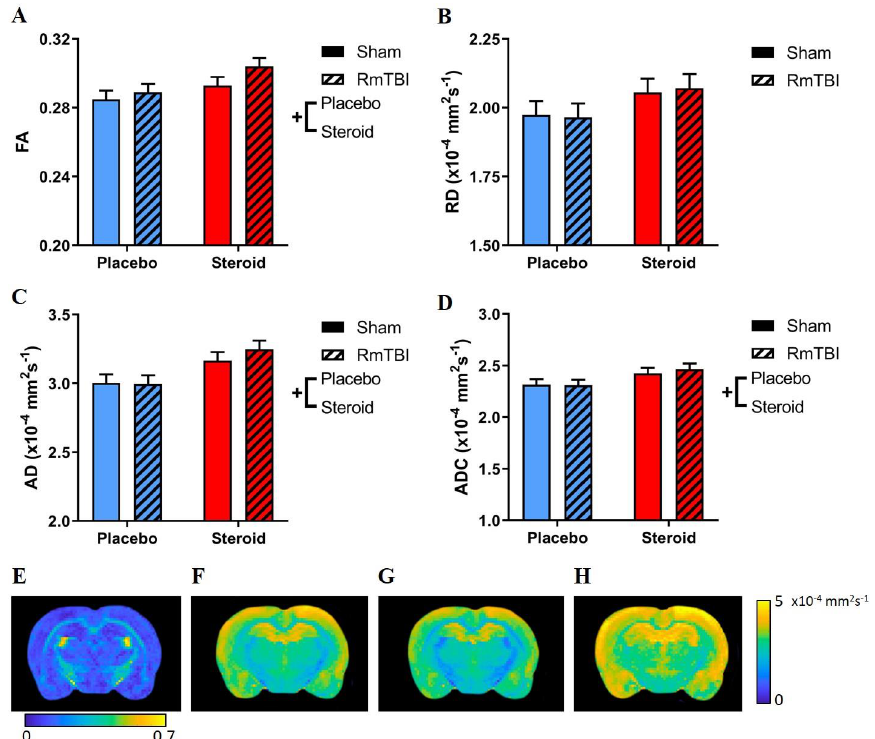
Figure 2. Diffusion-weighted MRI analysis of the CC. Bar graphs displaying DTI metrics. ( A ) FA; main effect of steroid treatment, whereby steroid groups had increased FA compared to placebo groups. ( B ) RD; no effects by steroid treatment or RmTBI.( C ) AD; main effect by steroid treatment, whereby steroid groups had increased AD compared to placebo groups. ( D ) ADC; main effect of steroid treatment, whereby steroid groups had increased ADC compared to placebo groups. ( E, F, G, H ) displaying example images FA, RD, AD, and ADC, respectively. Means ± standard error are displayed, where ( + )